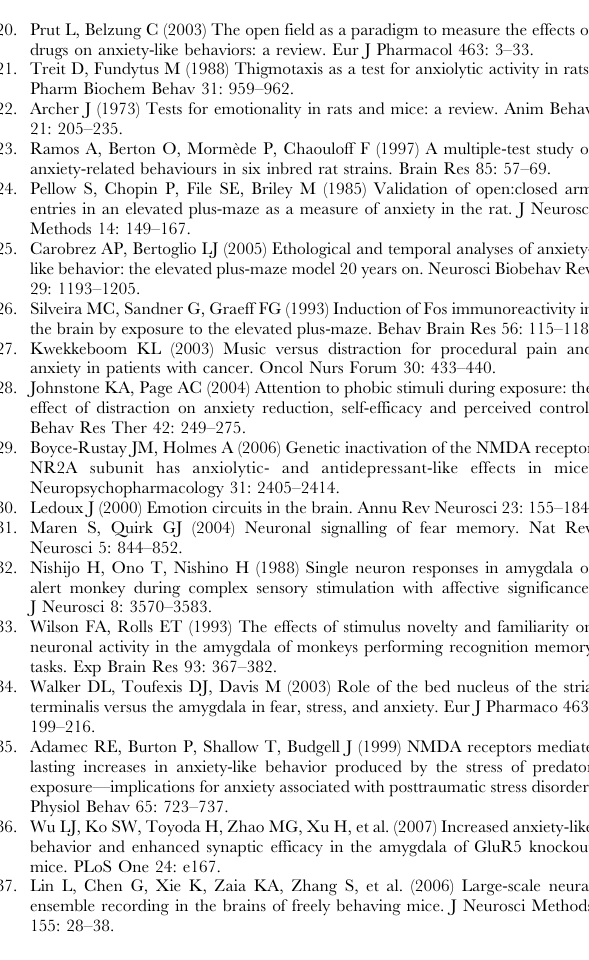
the recording position in the BLA. (D) Coronal diagrams showing locations of the electrode tips in the BLA across 8 mice. Numbers to the right, Anteroposterior coordinates (in millimeters) caudal to bregma. (TIF) Figure S2 Stable recording and isolation of BLA neu- rons. (A) Three well-isolated units (units 1-3) recorded from one tetrode clustered in Plexon Offline Sorter (top panel) and the representative waveforms for each unit on day 1 (bottom panels). (B and C) The same three units (as shown in A) and their representative waveforms on days 7 and 14.